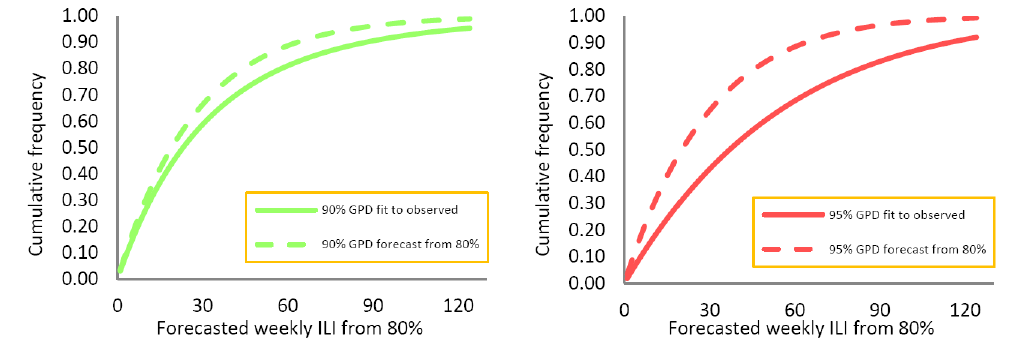
Figure 6. Forecasted magnitudes over the 90th and 95th percentile levels from the 80th percentile level in Duval